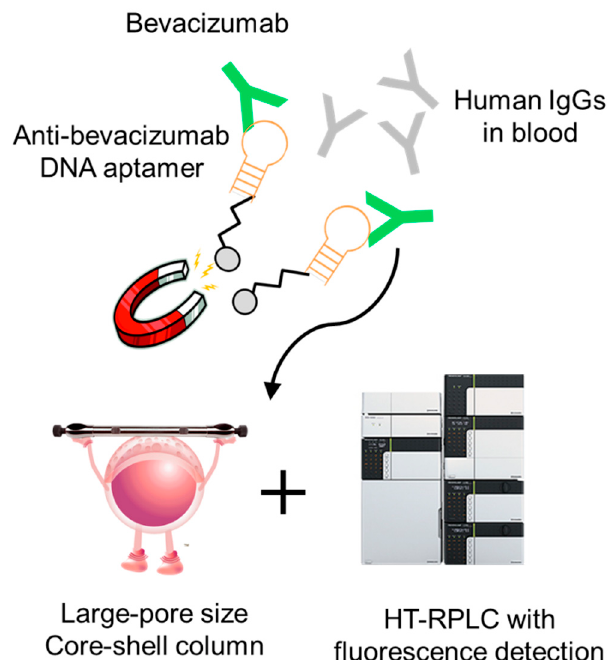
Figure 1. Schematic diagram of aptamer affinity purification–HT-RPLC for bevacizumab.